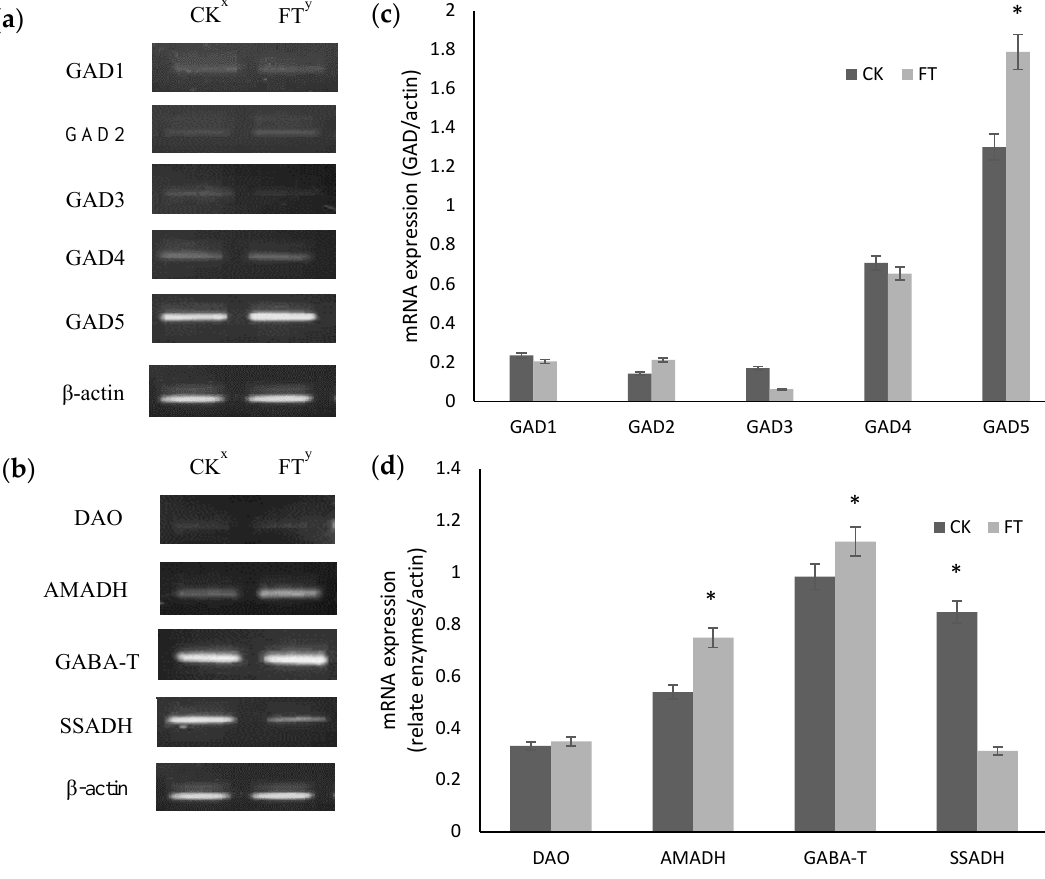
Figure 1. The mRNA expression of GABA-related enzymes in vegetable soybeans ‘Kaohsiung 9’ kernels with one-day flooding treatment. ( a ) Electrophoresis of PCR products from GAD1, GAD2, GAD3, and GAD5 expression. ( b ) Electrophoresis of PCR products from diamine oxidase (DAO), aminoaldehyde dehydrogenase (AMADH), GABA transaminase (GABA-T), and succinate semialdehyde dehydrogenase (SSADH). Densitometry analysis of β-actin relative expression of ( c ) GAD1, GAD2, GAD3 and GAD5, ( d ) DAO, AMADH, GABA-T, and SSADH. x Control. y Flooding treatment. p < 0.05, using Tukey’s test.